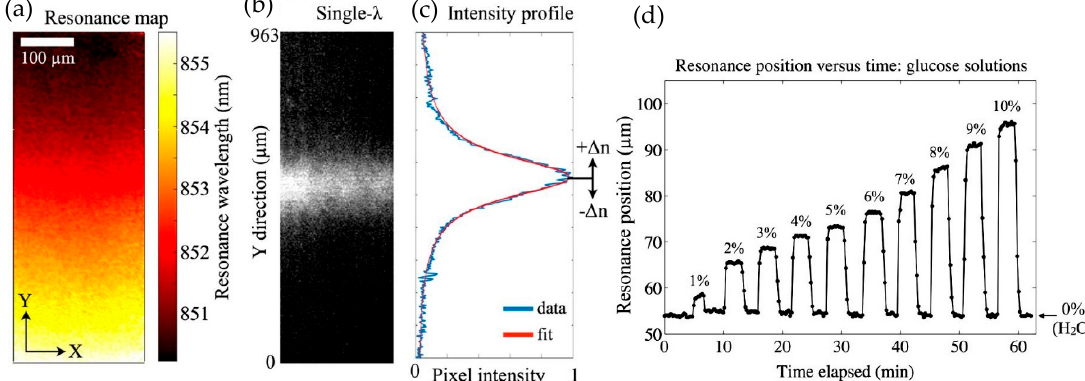
Figure 15. Experimental results presented in Triggs et al. [78]. ( a ) Resonance wavelength map when water is surrounding the gratings. ( b ) Measured brightfield image of the gratings when excited by a monochromatic light source. ( c ) Intensity profile of the measured resonance brightfield image shown in ( b ). The intensity profile is averaged and normalized. The change in refractive index of the grating cladding induces shift in the peak position of the intensity profile. ( d ) Shift in the peak position when the refractive index is changed by introducing different concentrations of glycerol. Water was added after each concentration measurement, which moved the peak position back to the original value (0% glycerol). Reprinted from [78] under CC BY 4.0.